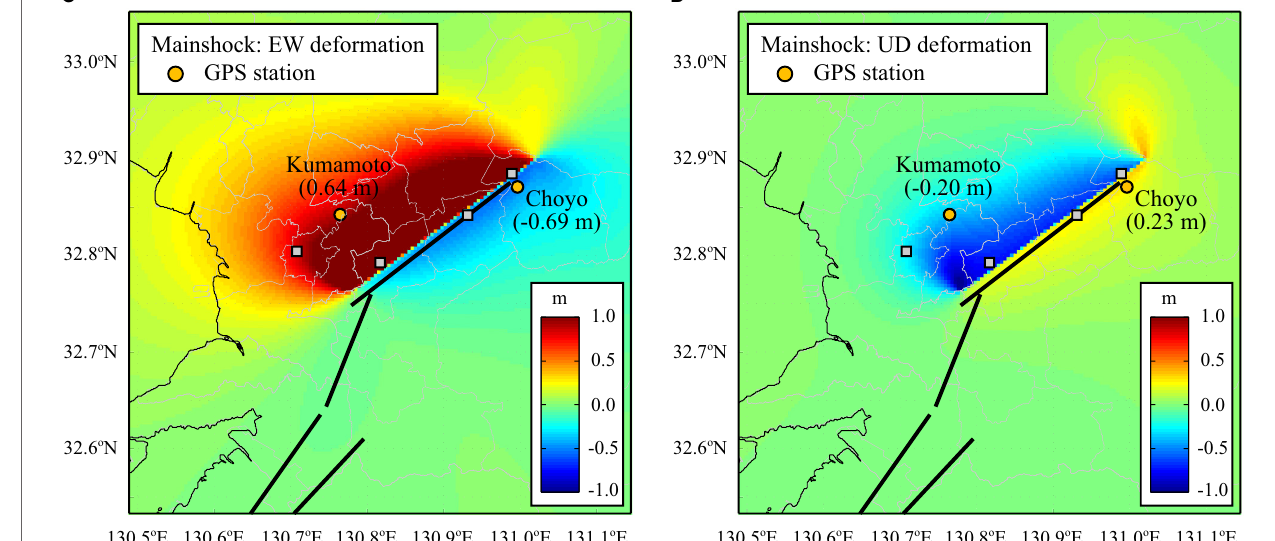
FigUre 4 | (a) Finite-fault models by Geospatial Institute of Japan (GSI) (2016) for the foreshock and mainshock. Estimated elastic deformation profiles based on the GSI finite-fault model for the mainshock: (B) NS deformation, (c) EW deformation, and (D) UD deformation.